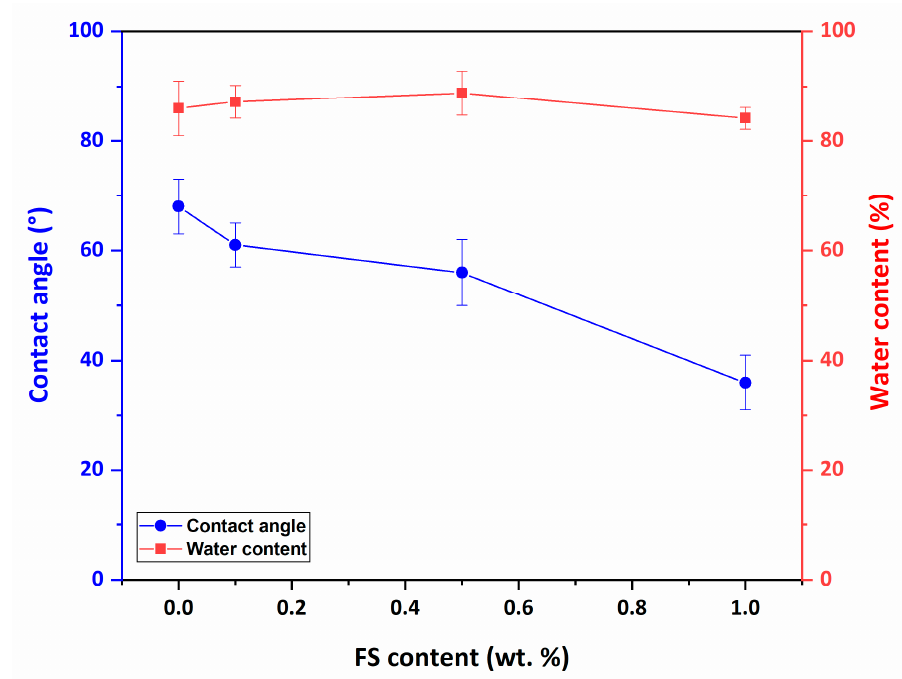
Figure 6. Contact angle and water content of PAN/FS